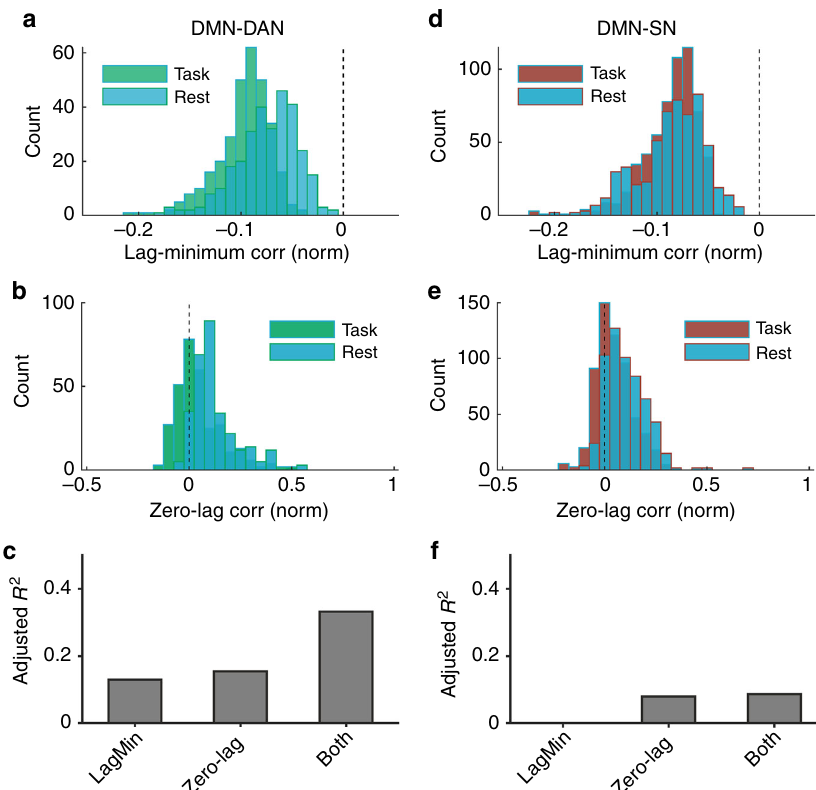
Fig. 6 Lag-minimum and zero-lag correlation of 0.1 – 1 Hz HFB signals during task performance and rest. a Histogram of the distributions of Fisher- transformed lag-minimum correlation values for all task-responsive DMN – DAN electrode pairs. b Histogram of the distributions of Fisher-transformed zero-lag correlation values for all task-responsive DMN-DAN electrode pairs. c The adjusted R 2 values for DMN – DAN linear mixed models with condition (task versus rest) as dependent variable and either lag-minimum correlation only, zero-lag correlation only, or both variables included as fi xed effects. d Histogram of the distributions of Fisher-transformed lag-minimum correlation values for all task-responsive DMN – SN electrode pairs. e Histogram of the distributions of Fisher-transformed zero-lag correlation values for all task-responsive DMN – SN electrode pairs. f The adjusted R 2 values for DMN – SN linear mixed models with condition (task versus rest) as dependent variable and either lag-minimum correlation only, zero-lag correlation only, or both variables included as fi xed